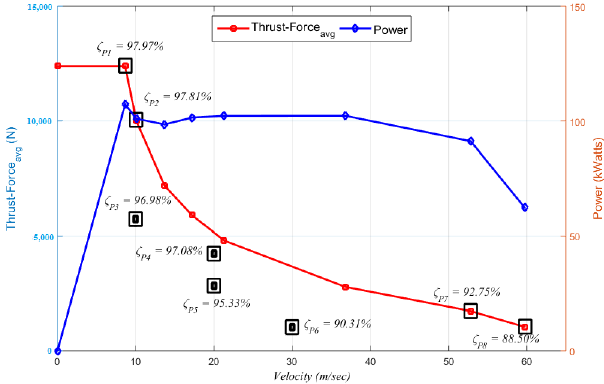
Figure 12. Average thrust force and power versus velocity.